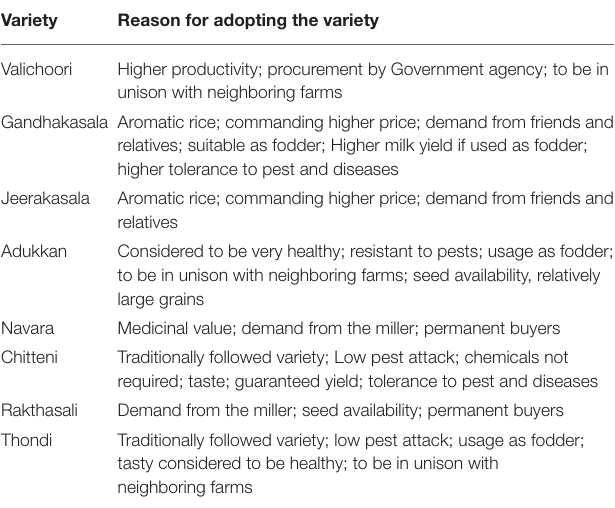
TABLE 3 | Reasons given by farmers for choosing to cultivate traditional varieties.